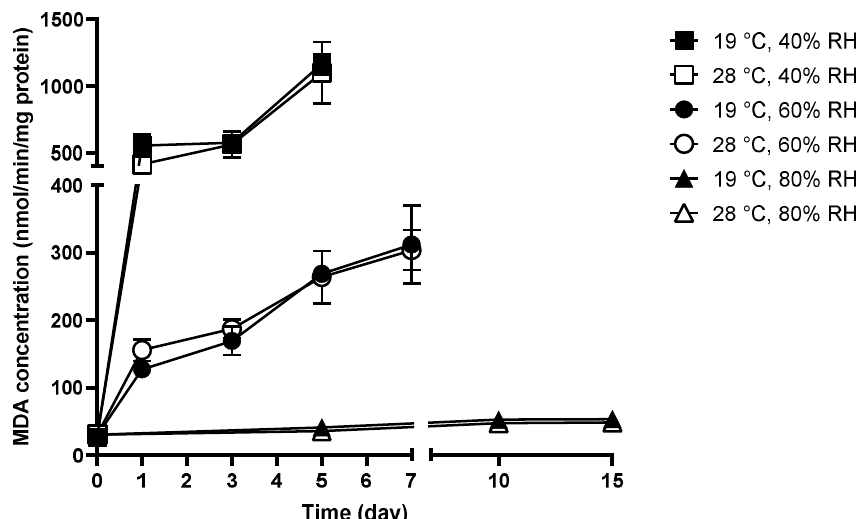
Figure 2. Lipid peroxidation level of C. cladosporioides spores exposed to moisture dynamics with different combinations of RH and temperature levels. The changes in MDA concentration under moisture dynamics were analyzed by repeated measures one-way-ANOVA. Grouping was performed by Duncan’s post-hoc test. Letters in parentheses indicate different groupings.